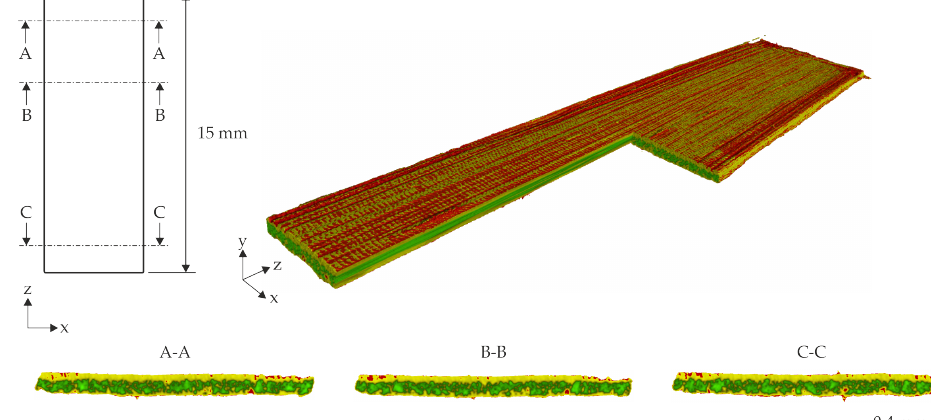
Figure 7. CT reconstruction of used PP GF 60 prepreg material; green—fibres, yellow—thermoplastic matrix,